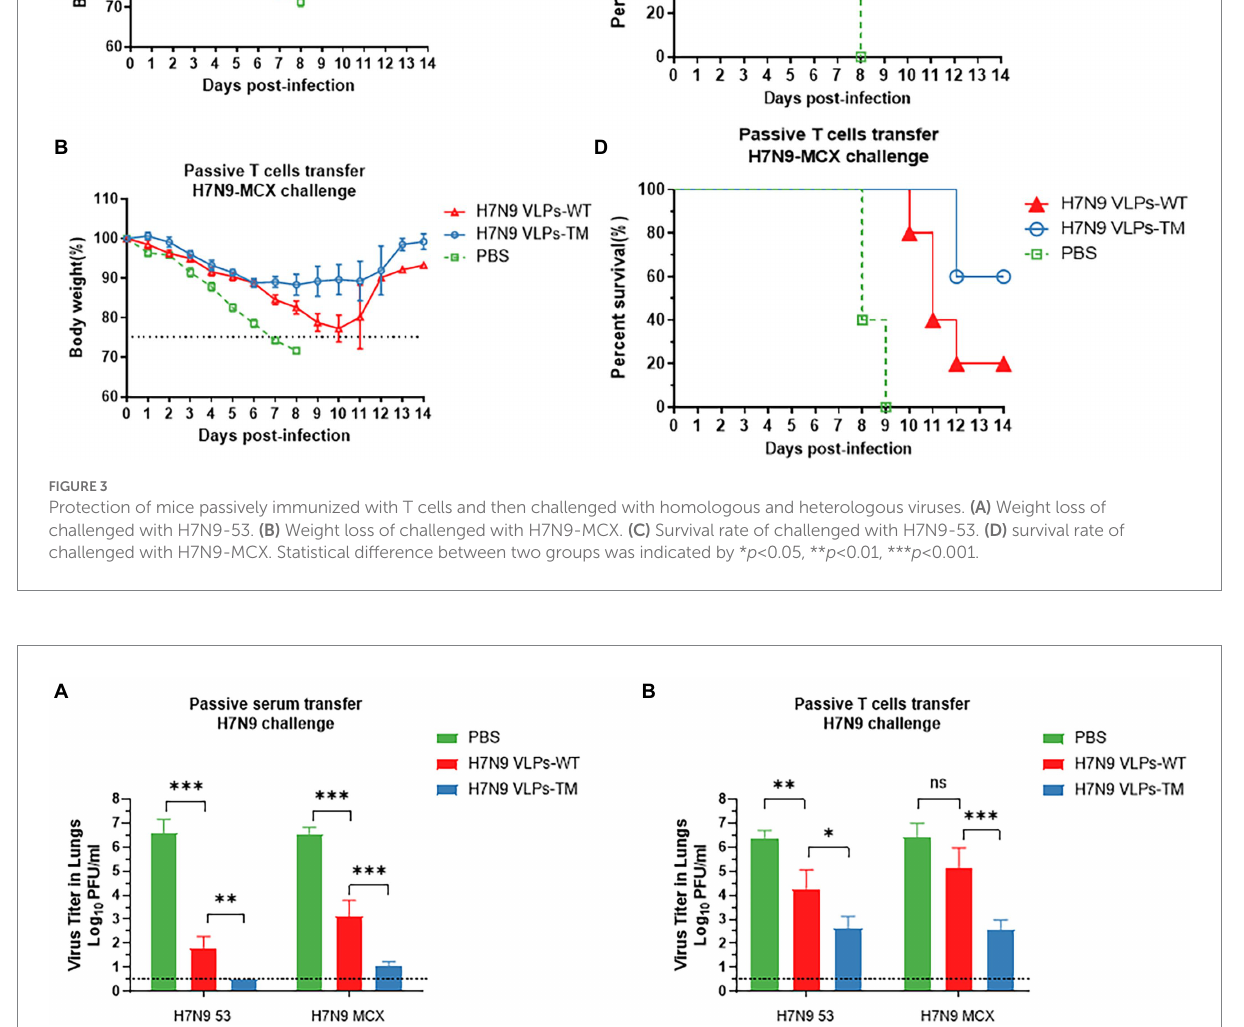
(Figure 5A, blue arrow), congestion, and bleeding (Figure 5A, green arrow). Both the H7N9 VLPs-WT and H7N9 VLPs-TM showed good protective effects against the challenge with the two viruses. In addition, it is worth mentioning that when H7N9-MCX was used, slight lymphocyte infiltration and exfoliated cells were observed in the alveolar cavities in the H7N9 VLPs-WT group